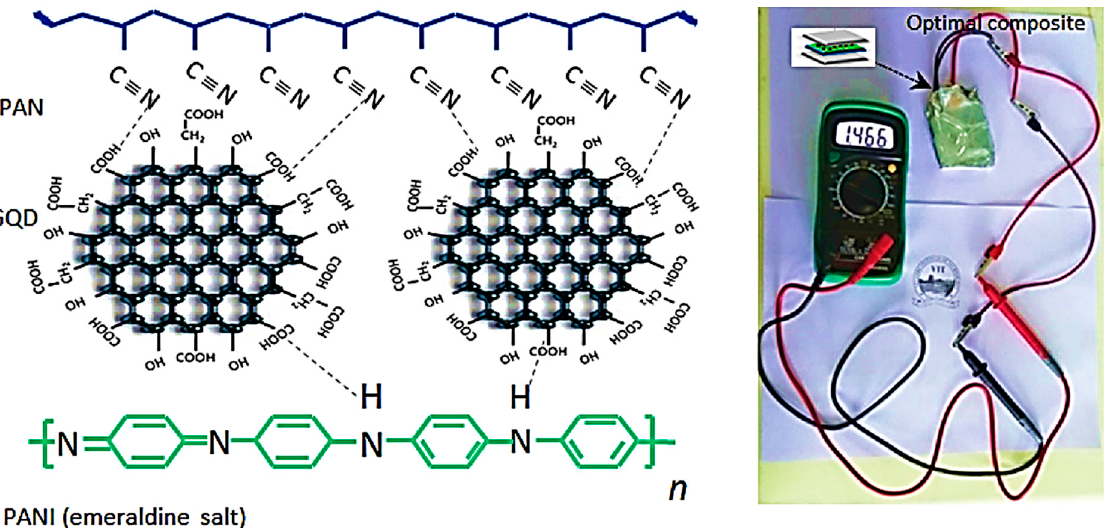
Figure 10. Illustration of PAN/PANI@G nanocomposite and its proton-coupled electron-transfer reaction responsible for the pseudocapacitance activity [124]. PAN/PANI@G = polyacryloni- trile/polyaniline@graphene; GQD = graphene quantum dot; PANI = polyaniline. Reproduced with permission from Elsevier.